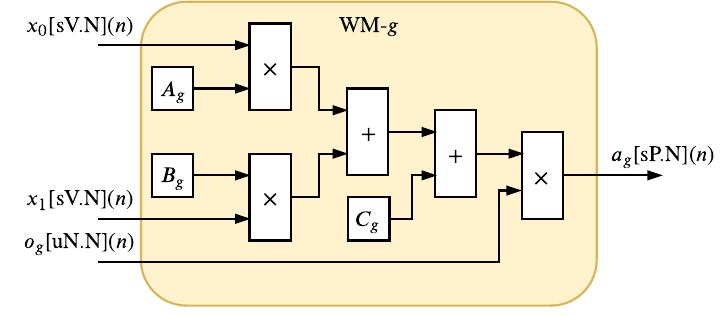
Figure 10. Hardware architecture of the NM.